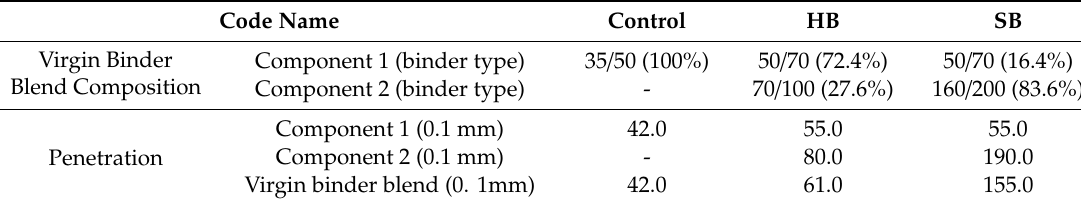
Table 4. Virgin binder